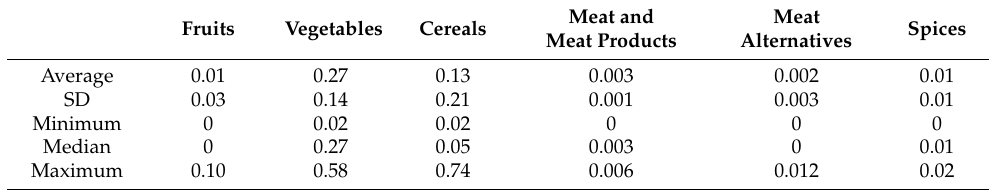
Table 10. Estimated amount of dietary salicylates in seniors’ diets from food groups (mg/day). Fruits Vegetables Cereals